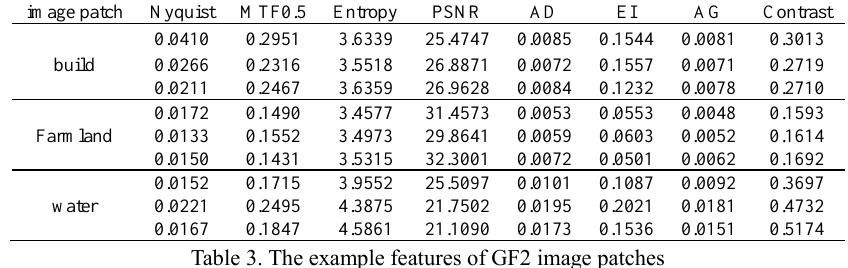
Table 3. The example features of GF2 image patches